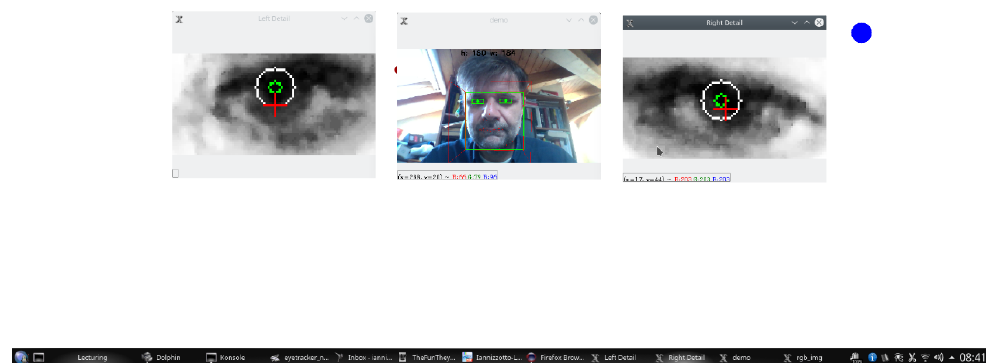
Figure 2. A screenshot demonstrating the adopted eye gaze tracking approach. The images are flipped horizontally. The blue circle marks the estimated target of the gaze on the screen.